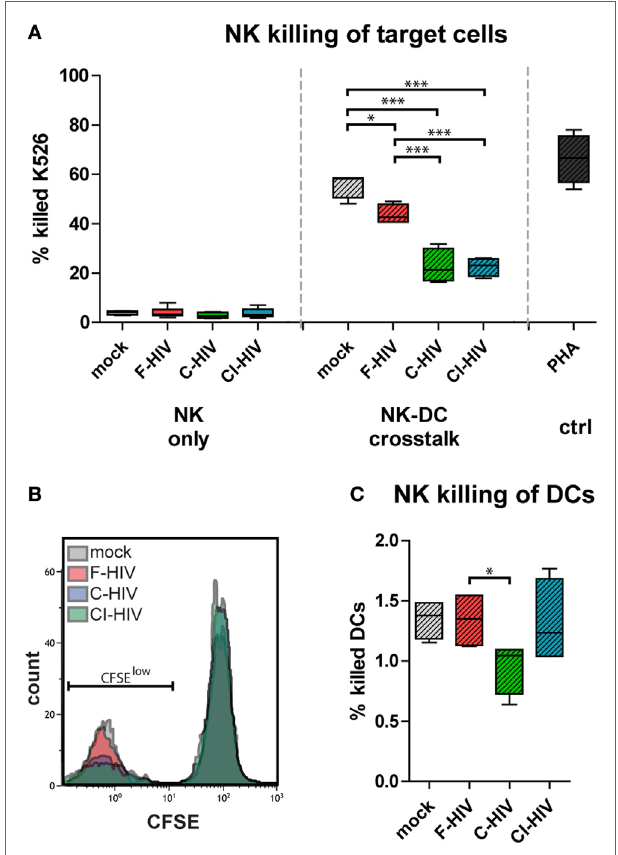
FigUre 5 | HIV decreased the cytotoxicity in natural killer (NK) cells activated by cross talk between NK cells and dendritic cells (DCs). NK cells were maintained in single NK cell cultures, or in cross talk cultures consisting of NK cells and DCs from the same donor at a 1:1 ratio and exposed to 1 μ g/ ml F-HIV, complement-opsonized HIV (C-HIV), CI-HIV, PHA, or mock treated for 24 h. The experiment was replicated four times using cells derived from four different donors. (a) NK cells from single or purified from the cross talk assays were added to target cells (CFSE-stained K562 cells) at a 1:8 ratio for 6 h and the amount of killed cells were assessed using flow cytometry. (B) Representative histograms for the different experimental conditions. (c) A similar assay was performed, using CFSE-stained DCs as target cells. Boxplots show mean with Tukey error bars. One-way ANOVA followed by a Bonferroni posttest was used to test for statistical significance (* p < 0.05, N = 4).